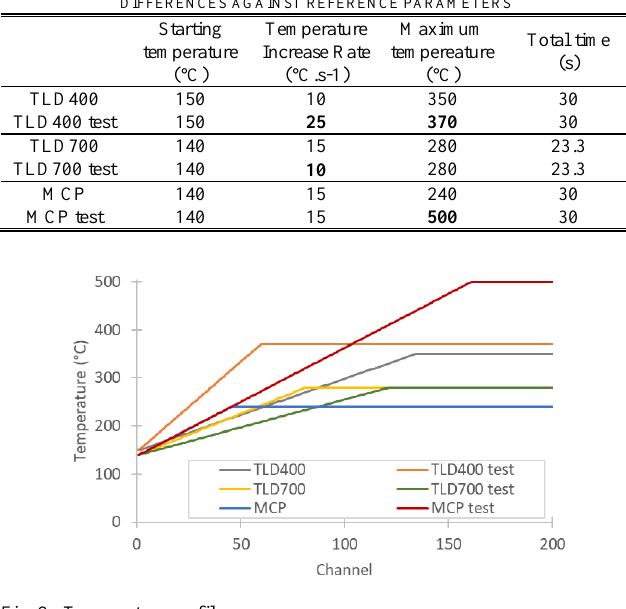
Fig. 2. Temperature